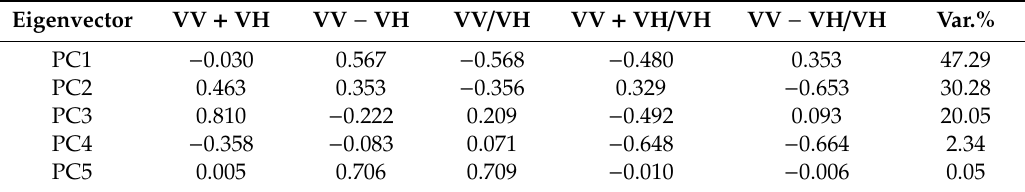
Table 3. Eigenvector loadings of PCA for Sentinel-1B band math images.